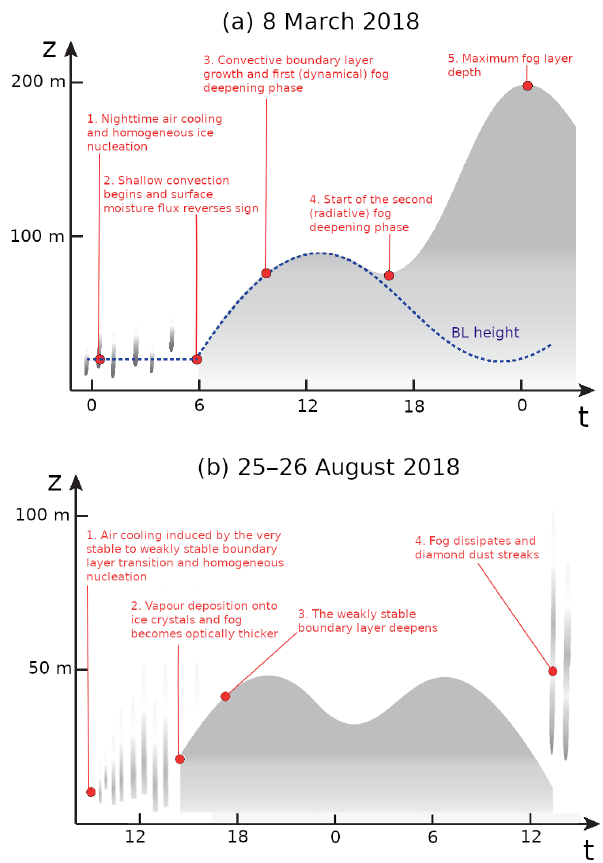
Figure 10. Conceptual scheme of the formation and growth of the two ice fogs studied in the